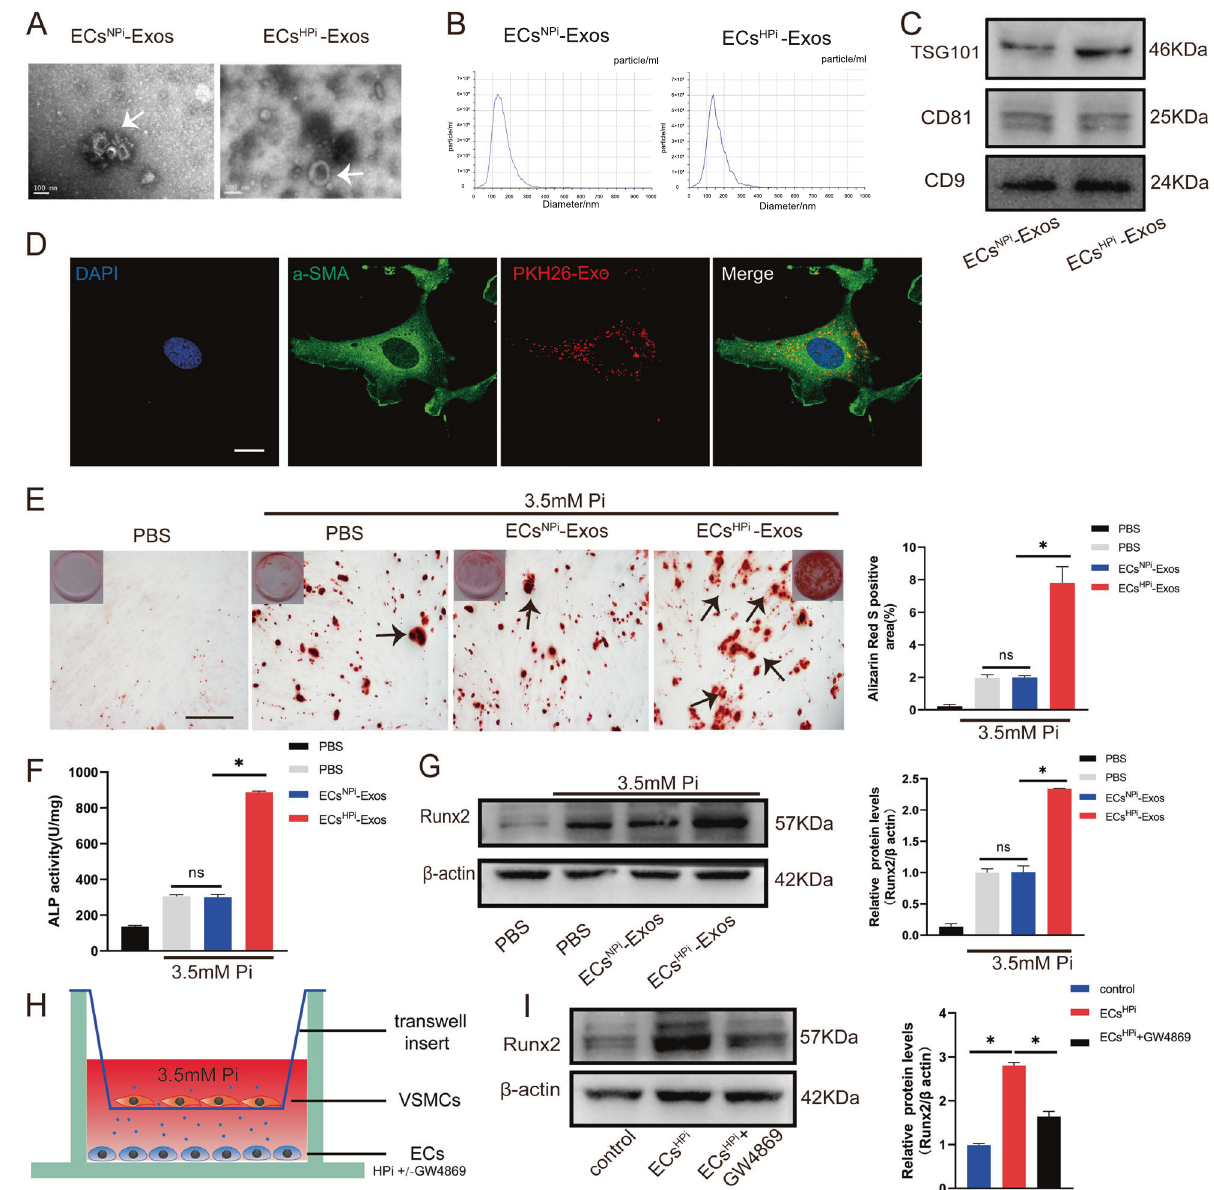
Fig. 2 Exosomes secreted from high phosphorus-stimulated ECs exacerbated VSMCs calci fi cation. A Transmission electron micrographs of exosomes derived from ECs NPi -Exos or ECs HPi -Exos phosphate conditions (Bar = 100 nm). B The nanoparticle concentration and size distribution of the ECs-Exos. C CD9, CD81, and TSG101 immunoblots of exosomes. D VSMCs were incubated with PKH26 fl uorescently labeled exosomes for 12 h. Confocal microscopy analysis was used to identify the uptake of EVs by VSMCs (PKH26 in red, DAPI in blue, and α -SMA in green) (Scale bar = 5 μ m). E VSMCs were incubated with ECs NPi -Exos and ECs HPi -Exos for 48 h, respectively. Then, Alizarin Red S staining was performed and calcium content was measured in VSMCs. The black arrows indicate mineralized nodules in VSMCs (Scale bar = 200 μ m). F ALP activity was measured by an ALP kit in VSMCs incubated with ECs NPi -Exos and ECs HPi -Exos. G The expression of Runx2 was determined by Western blot in VSMCs incubated with ECs NPi -Exos and ECs HPi -Exos. H , I ECs in the lower chamber pre-treated with or without GW4869 were co-cultured with VSMCs in six-well Transwell units, and the upper chamber VSMCs were harvested to determine the expression of Runx2 by using western blot. Three independent experiments were performed, and representative data were shown. Data are shown as mean ± SD. ns: no signi fi cance, * p <